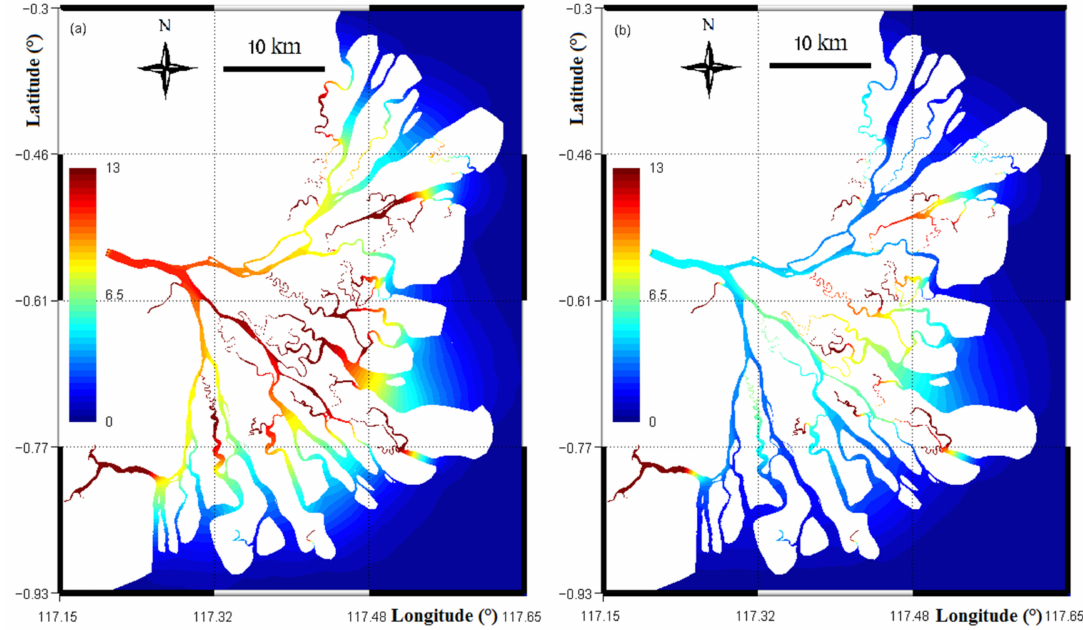
Figure 12. Distribution of the exposure time in the whole delta for the: ( a ) low; ( b ) high flow period. The color bar is cropped at 13 days in order to focus on the variation of the exposure time in deltaic channels and the unit is